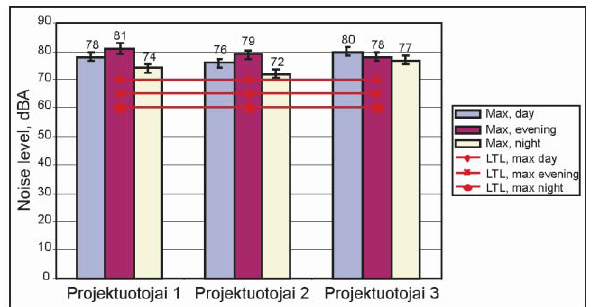
Fig. 17. Dynamics of maximum noise levels in Projektuotojai street within twenty four hours